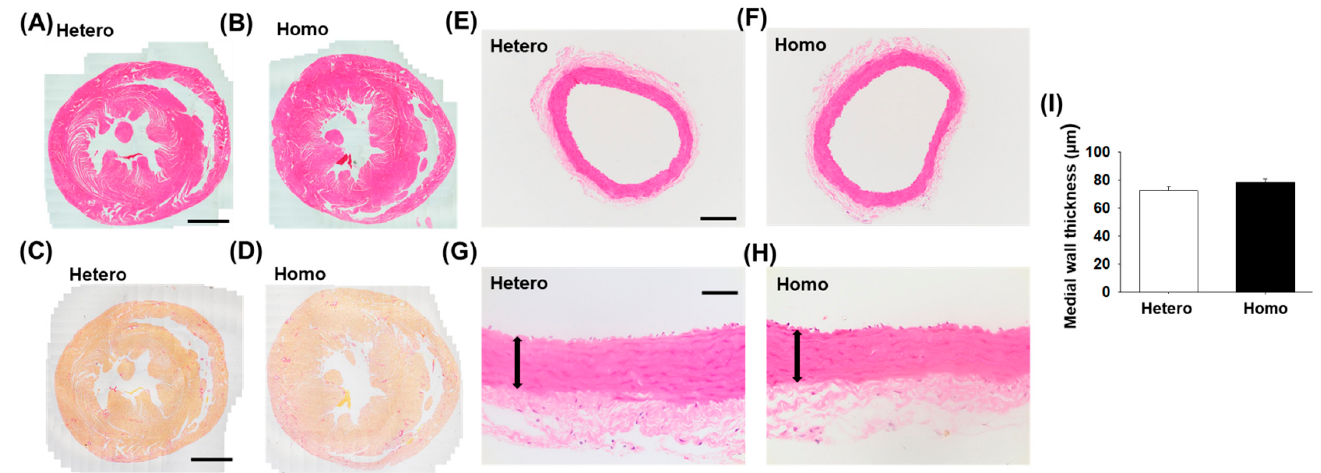
Figure 3 . Histological analysis of ventricles and mesenteric arteries from ZFDM rats. Thin sections (4 μ m) were made from paraffin-embedded isolated ventricles and mesenteric arteries from ZFDM rats at 36–38 weeks old (Hetero: n = 8, Homo: n = 9). ( A , B ) Representative hematoxylin and eosin (HE)-stained sections for ventricles. ( C , D ) Representative picrosirius red stained sections (4 μ m) for ventricles. Collagen was stained in red, and cytoplasm was stained in yellow. ( E – H ) Representative HE-stained sections for mesenteric arteries. ( I ) Medial wall thickness of the mesenteric arteries was calculated and shown as means ± SEM. Scale bar: 2 μ m ( A , C ), 100 μ m ( E ), and 50 μ m ( G ). Arrow: medial wall of the artery.